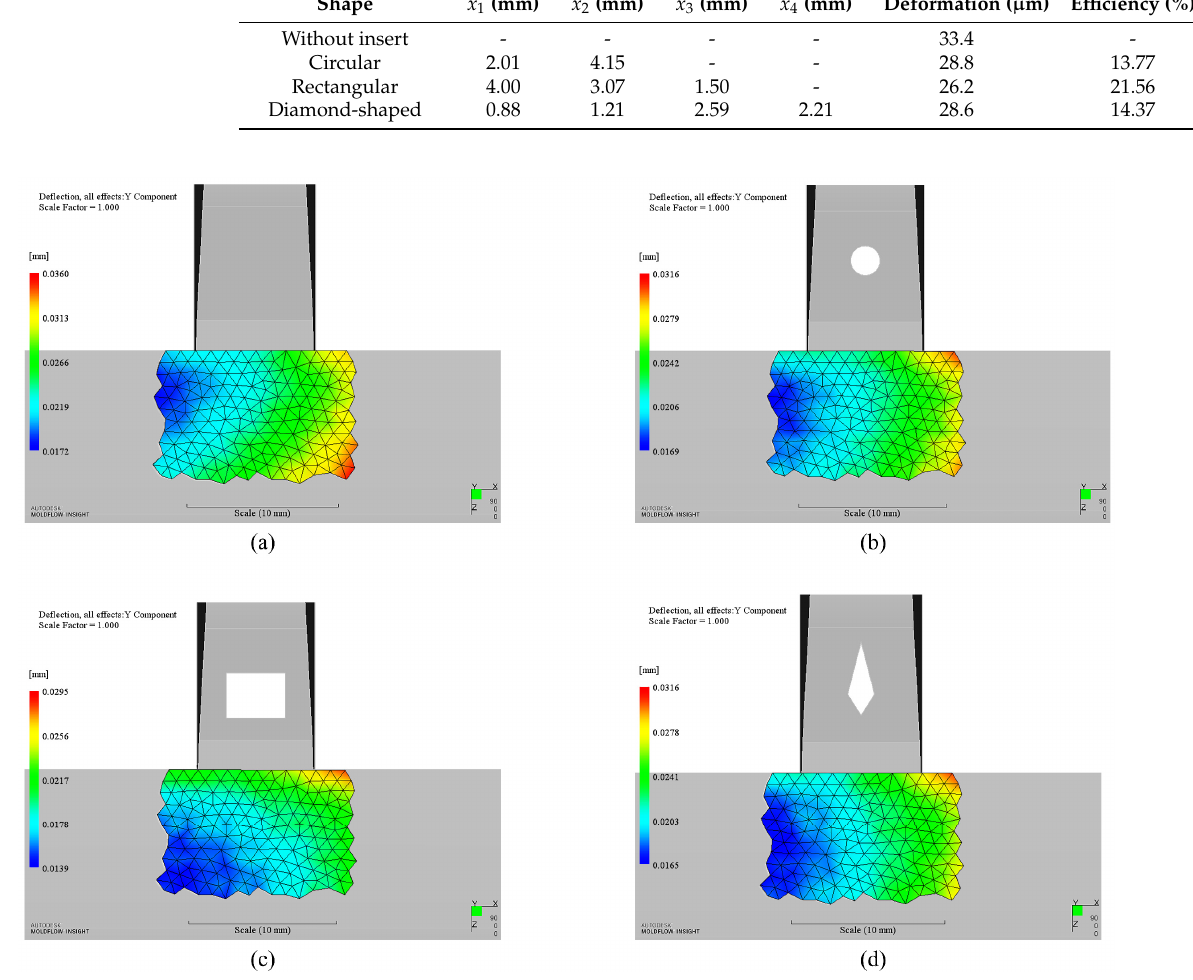
Figure 6. Deformation contour of optimization cases: ( a ). Without insert; ( b ). Circular insert (optimized); ( c ). Rectangular insert (optimized); ( d ). Diamond-shaped insert (optimized).